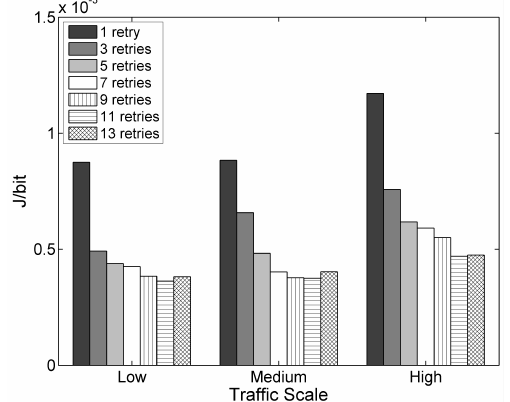
Figure 7. The average energy efficiency for different values of macMaxFrameRetries in different traffic